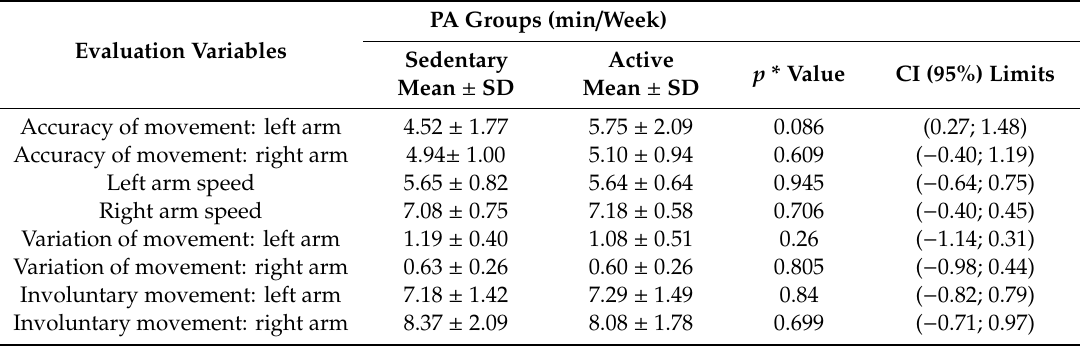
Table 6. Upper limbs. Di ff erences between sedentary and active participants.